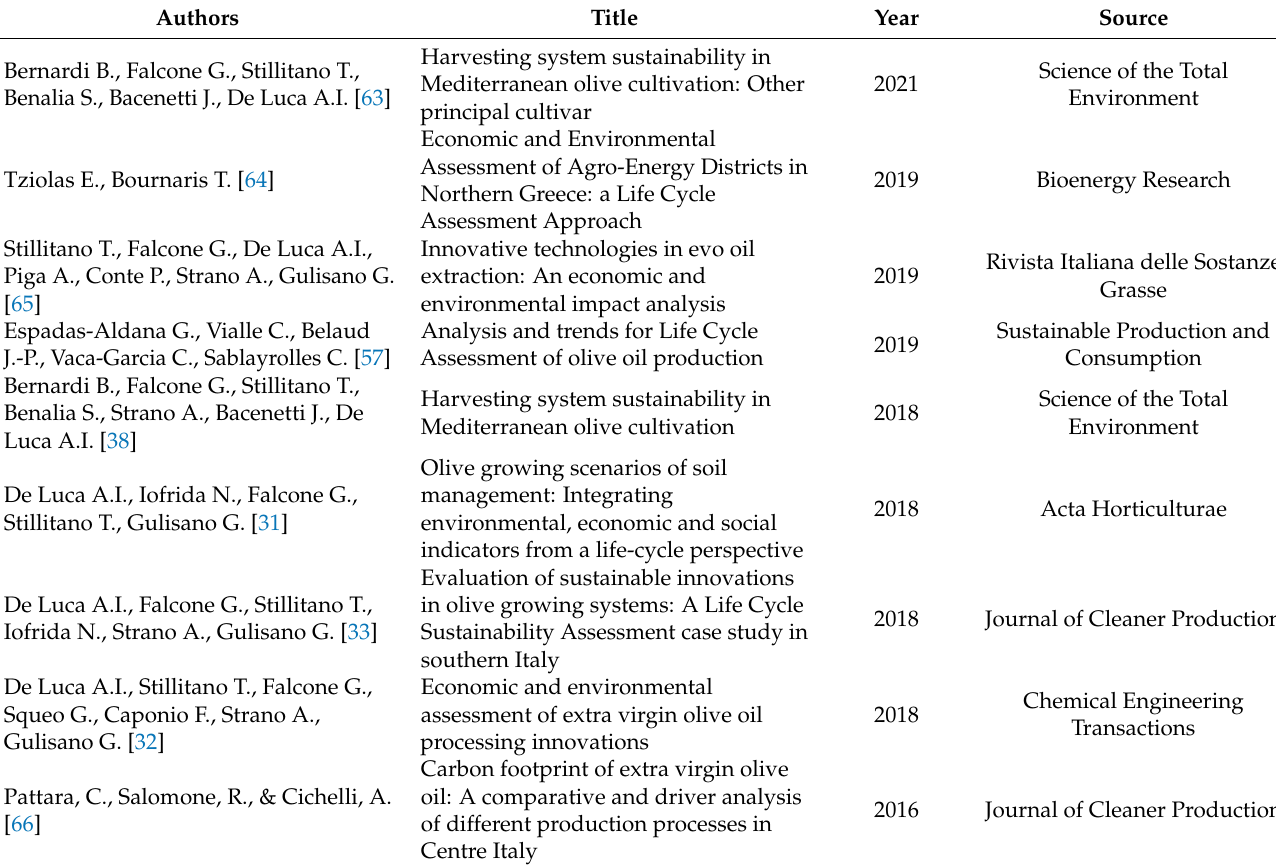
Table 2. Analysis of the literature reporting on LCA tools in the olive